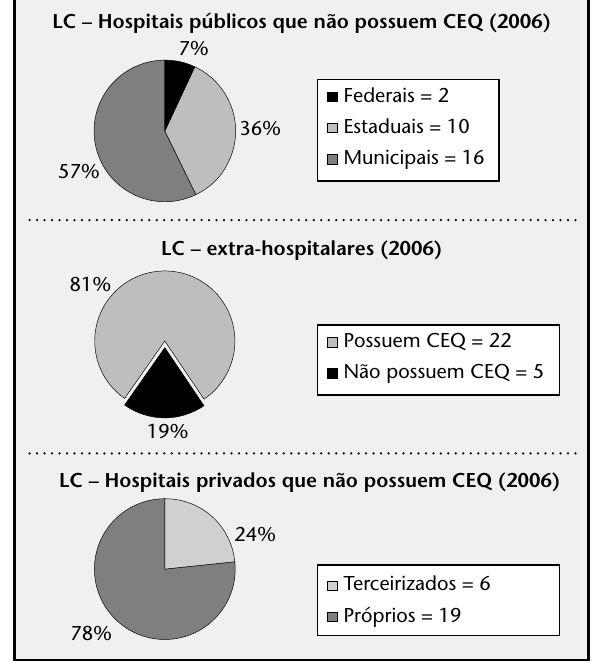
Figura 1 – Total de LCs (ano 2006) que não possuíam CEQ = 58 LC: laboratório clínico; CEQ: controle externo de qualidade.